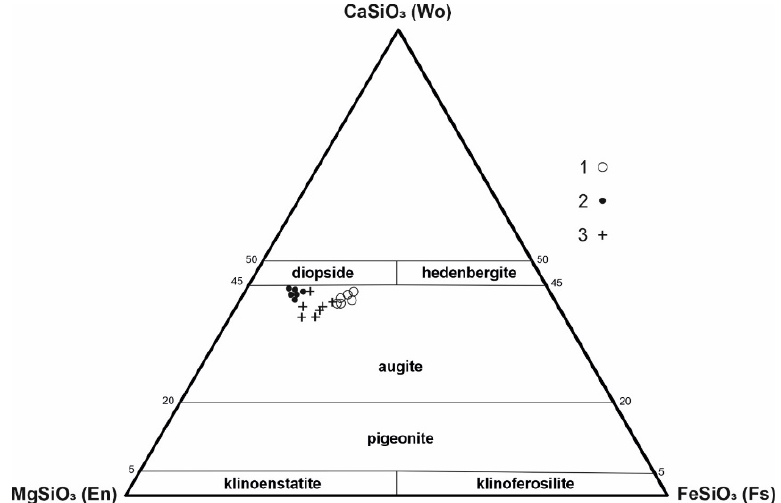
Figure 3. Classification diagram of clinopyroxenes [49]. 1—sample M-1; 2—sample M-8; 3—sample M-9.